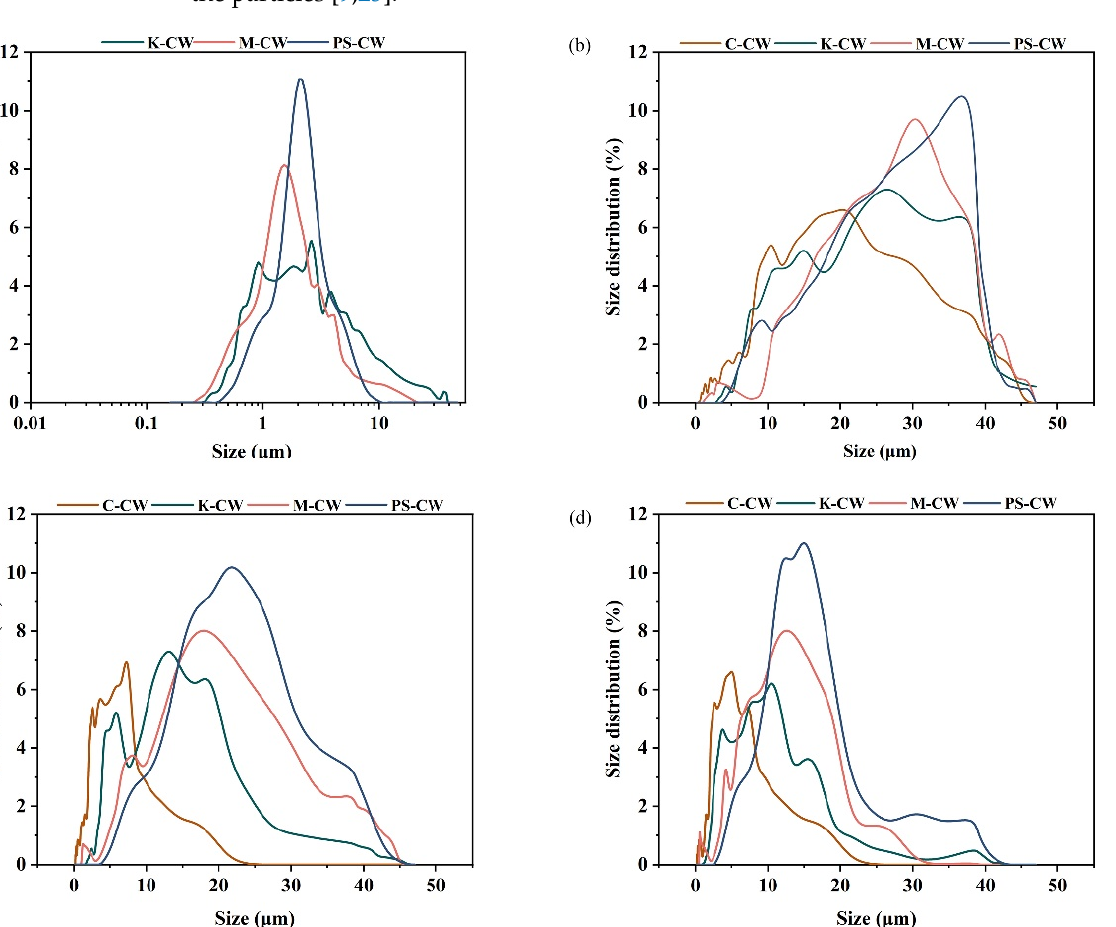
Figure 4. SEM micrographs of the substrates at the end of experiment. ( a ) C–CW, ( b ) K–CW, ( c ) M– CW and ( d ) PS–CW.